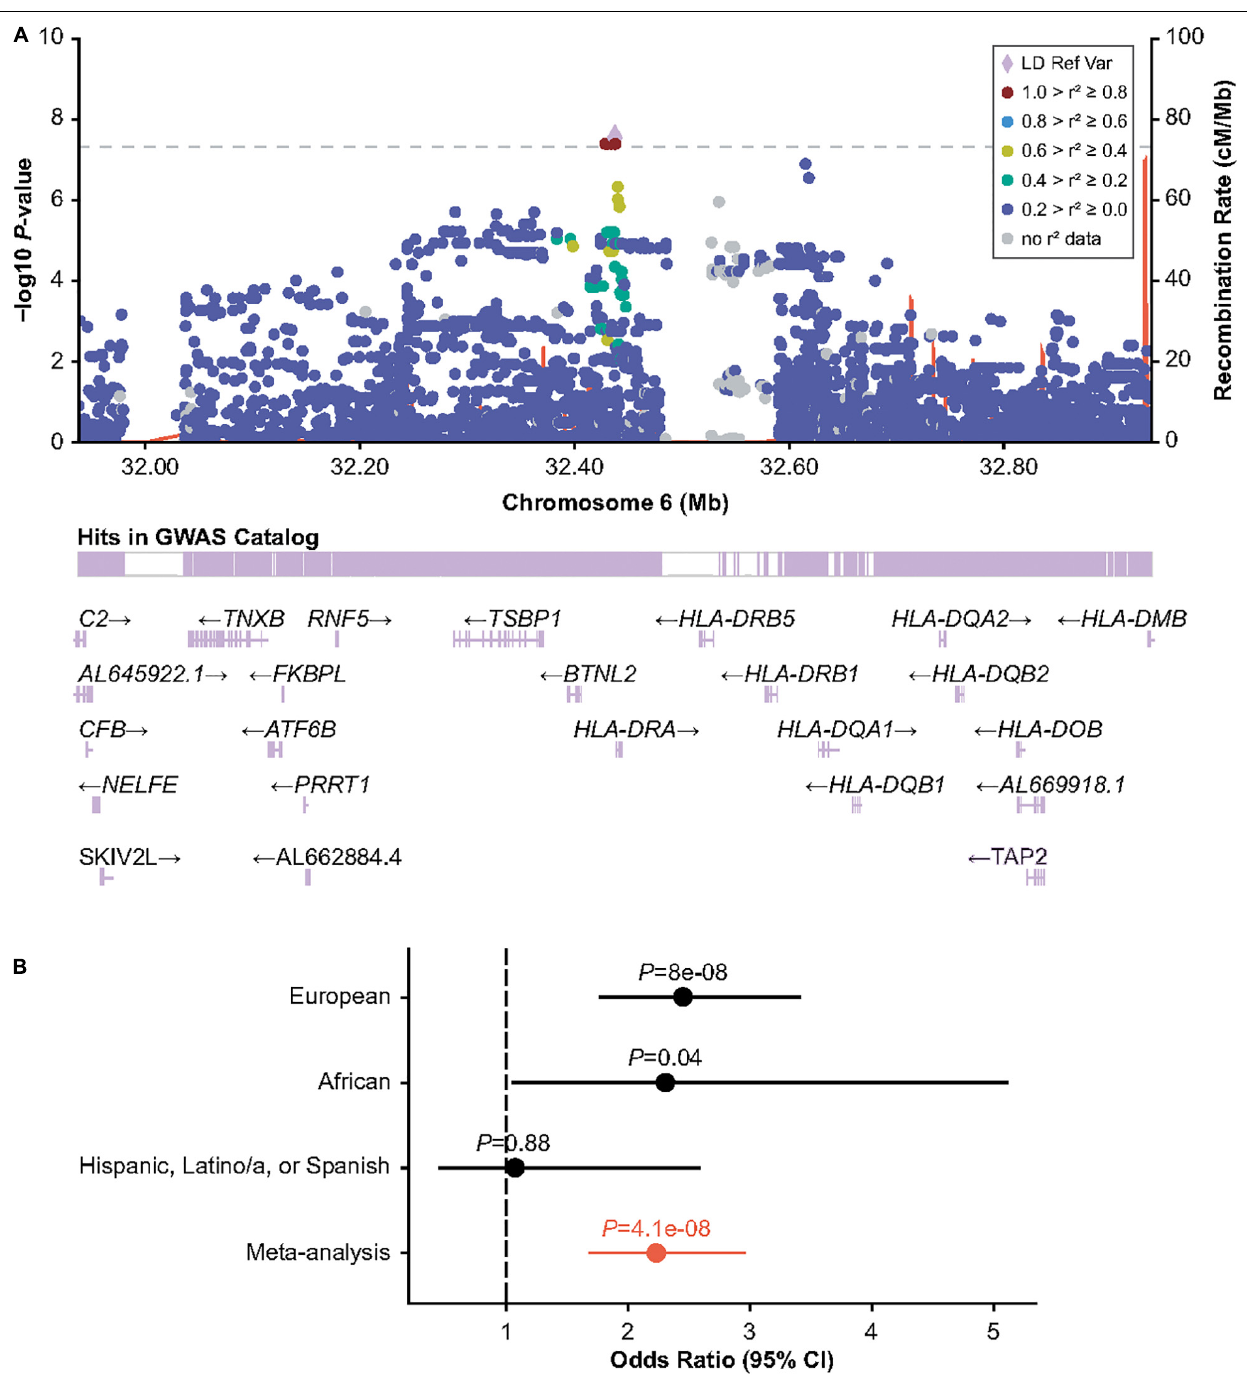
Frontiers in Medicine |